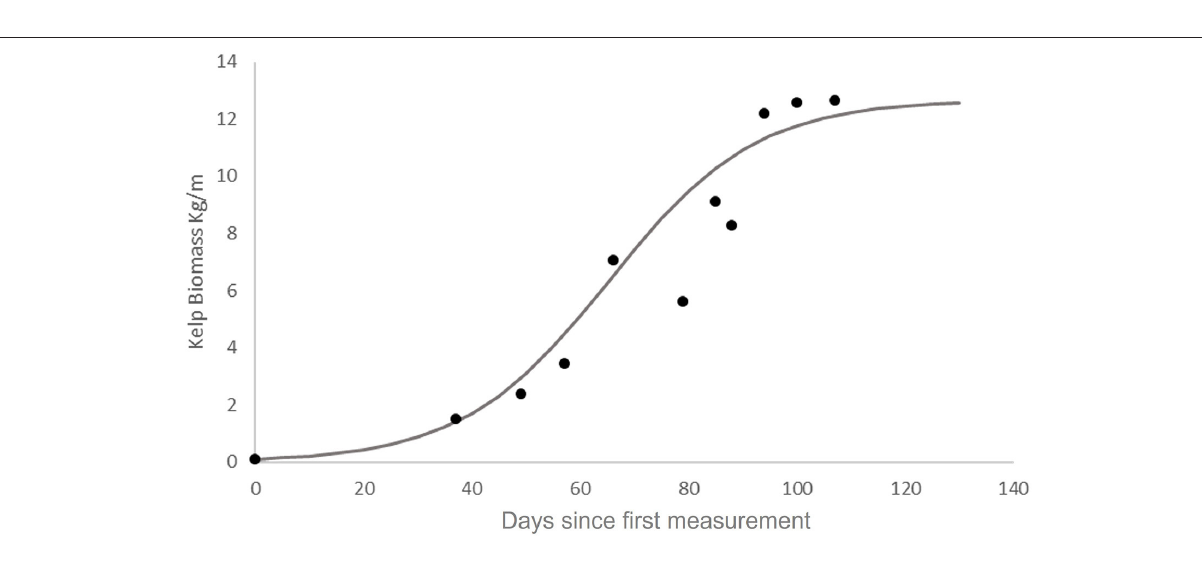
FIGURE 4 | Kelp biomass data fit to a logistic growth